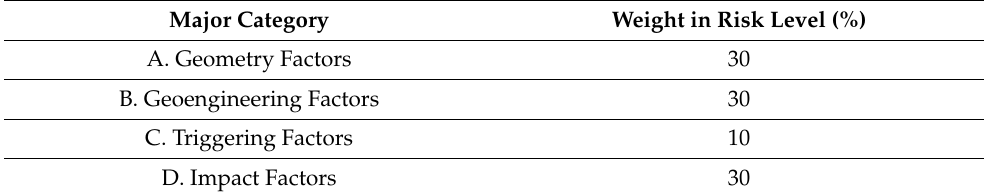
Table 6. The main categories of rating factors and their weight for the proposed rating